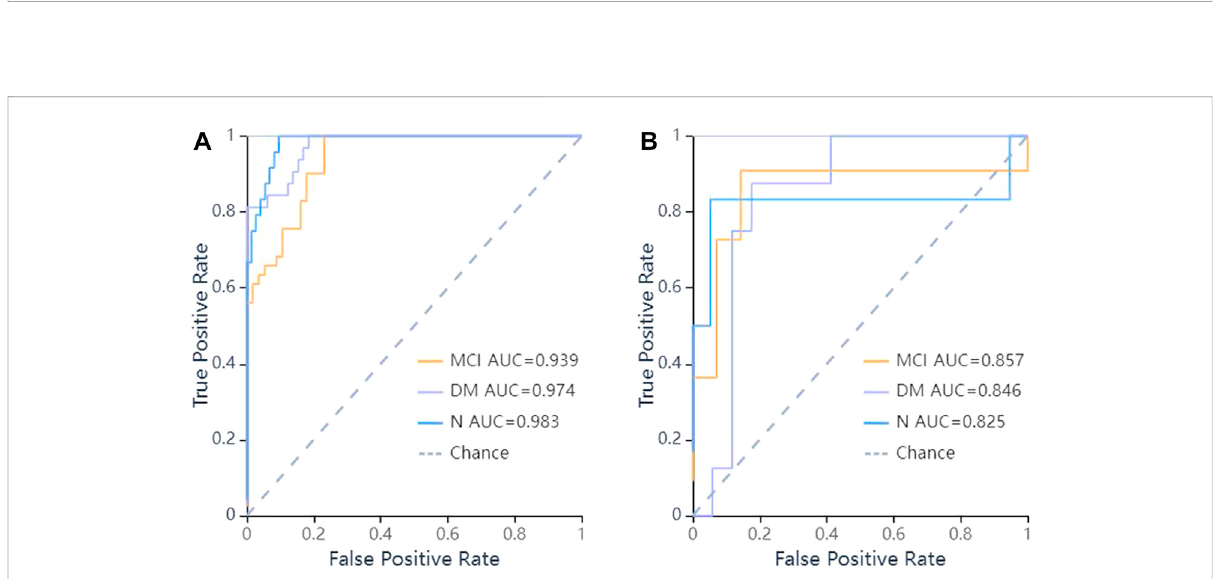
FIGURE 6 ROC curves ofSVMmethodsto classi fi cation. (A) ROC curveoftraining set, theAUC were0.974 inDM(sensitivity andspeci fi citywere0.84and {"MCI ” : 0.82, “ DM ” : 0.92, “ N": 0.97}), 0.939 in MCI (sensitivity and speci fi city were 0.85 and {"MCI ” : 0.82, “ DM ” : 0.92, “ N": 0.97}), 0.983 in N (sensitivity and speci fi city were 0.75 and {"MCI ” : 0.82, “ DM ” : 0.92, “ N": 0.97}) respectively; (B) ROC curve of validation set, the AUC were 0.846 in DM (sensitivity andspeci fi citywere0.88and{"MCI ” :0.86, “ DM ” :0.76, “ N":0.95}),0.857inMCI(sensitivityandspeci fi citywere0.73and{"MCI ” :0.86, “ DM ” :0.76, “ N": 0.95}), 0.825 in N (sensitivity and speci fi city were 0.50 and {"MCI ” : 0.86, “ DM ” : 0.76, “ N": 0.95})